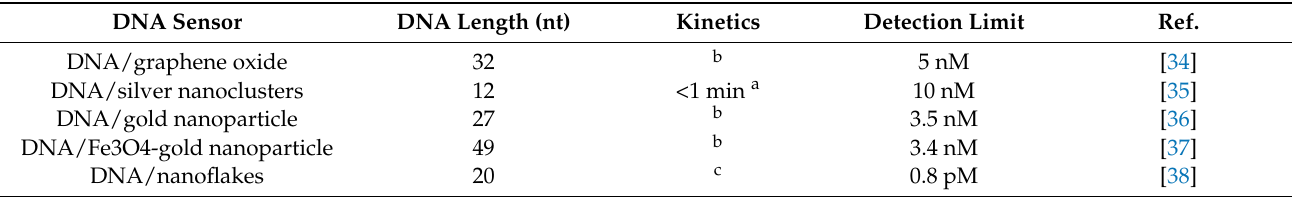
Table 2. Literature survey on DNA-based sensors for Ag + detection. DNA Sensor DNA Length (nt) Kinetics Detection Limit Ref. DNA/graphene